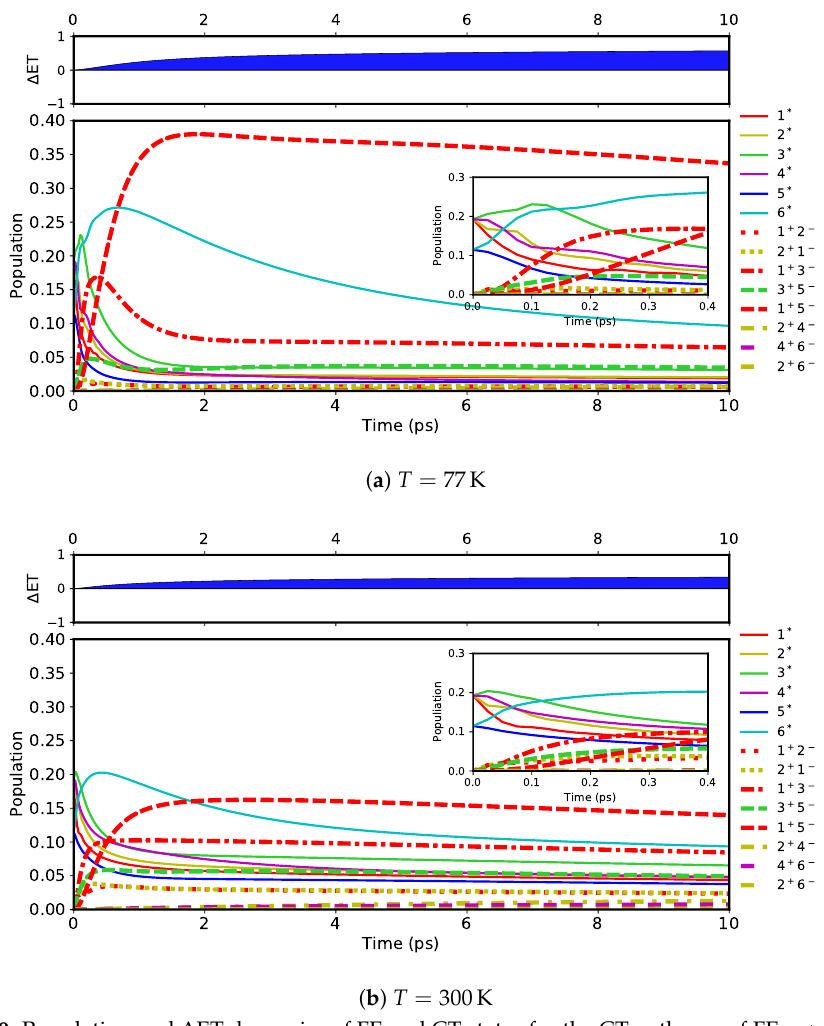
Figure 9. Population and ∆ ET dynamics of FE and CT states for the CT pathway of FEs → | 1 + 3 − (cid:105) → | 1 + 5 − (cid:105) . Out of the 36 states used for computations, only the selected 14 states are displayed for clarity. The levels shifts are set to ∆ E 3 = − 2900cm − 1 , ∆ E 5 = − 6000cm − 1 , and ∆ E 2 = ∆ E 4 = ∆ E 6 = 0. ∆ ET at each moment of time t has been computed by setting τ = t in Equation (7). The insets show the populations for the first 400 fs. ( a ) Results for 77K. ( b ) Results for